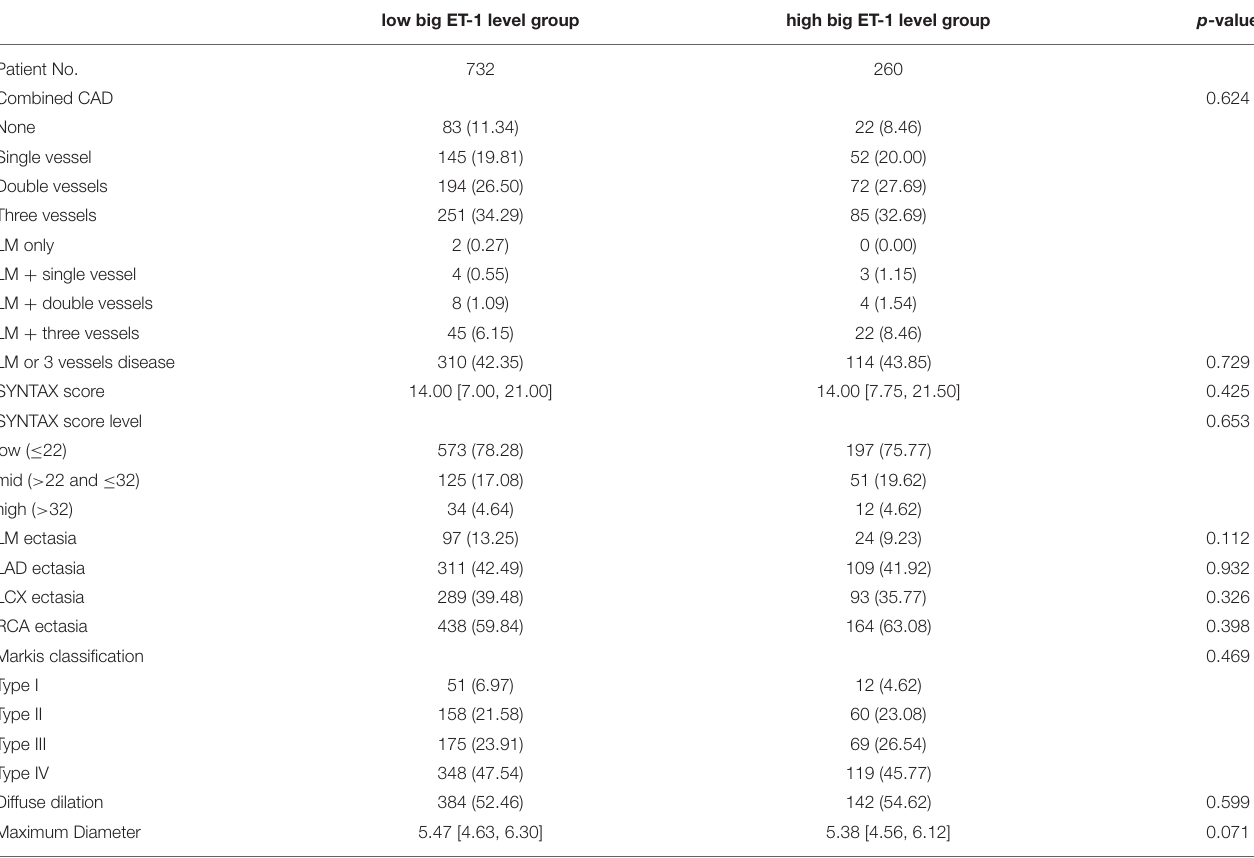
TABLE 2 | Angiographic characteristics of the study population. low big ET-1 level group high big ET-1 level group p -value Patient